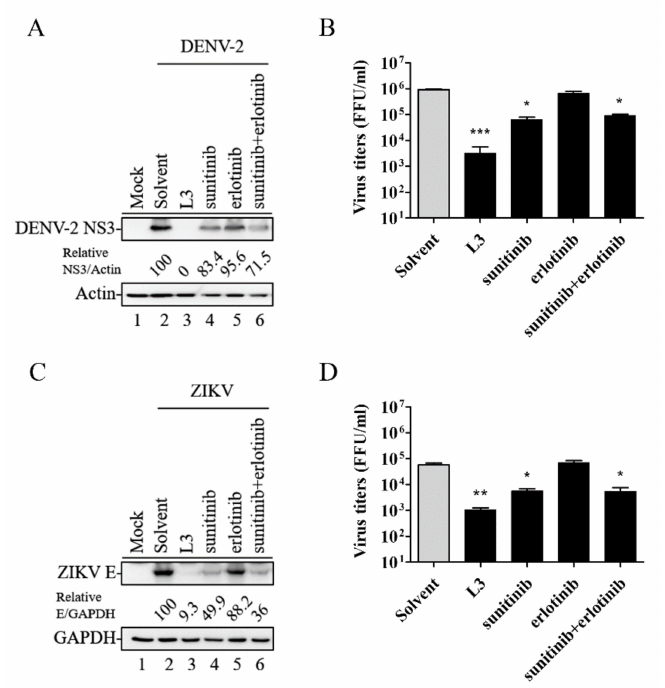
Figure 3. Compound L3 significantly inhibited DENV-2 or ZIKV compared to other tyrosine kinase inhibitors. HEK-293 cells were infected with DENV-2 ( A , B ) or ZIKV ( C , D ) and treated with 10 µ M of either compound L3 or the indicated drugs for 36 h. Viral protein expression ( A , C ) and virus titers ( B , D ) were analyzed and adjusted to those of the solvent control. Data are the mean ± SD of three independent experiments. * p < 0.05, ** p < 0.01, *** p < 0.001 according to a two-tailed Student’s t